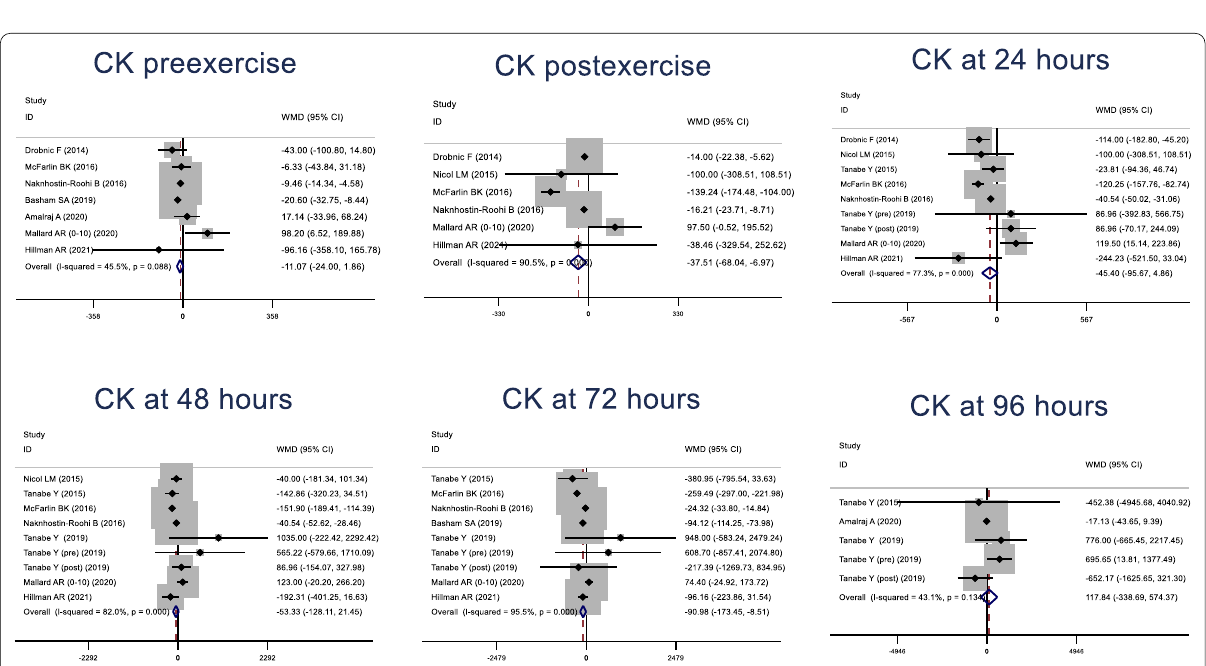
Fig. 3 Forest plot for comparison of CK score at pre-, post-, 24, 48, 72 and 96 h after exercise between curcumin supplement versus